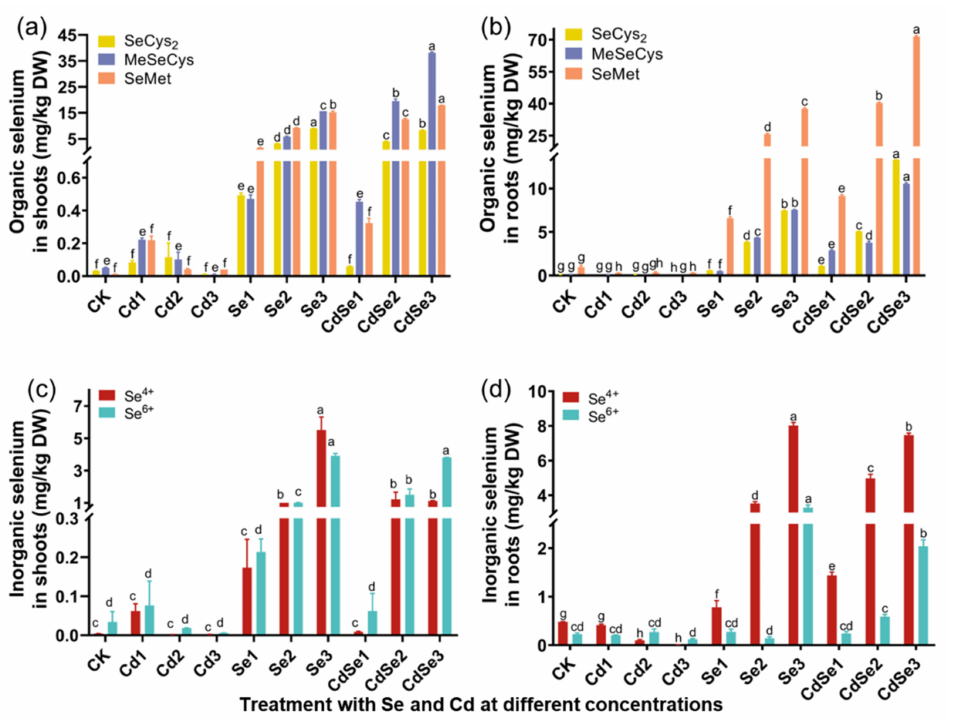
Figure 8. Changes in Se species contents in seedlings after treatment with different concentrations of CdCl 2 and Na 2 SeO 3 . The error bar represents the standard deviation. The lowercase letter a to h on the bar reflects the 5% significance level. ( a ) Changes in the content of three organic Se in the shooting part; ( b ) changes in the contents of three organic Se in the root part; ( c ) changes in the contents of two inorganic Se in the shooting part; and ( d ) changes in two inorganic Se contents in the root.